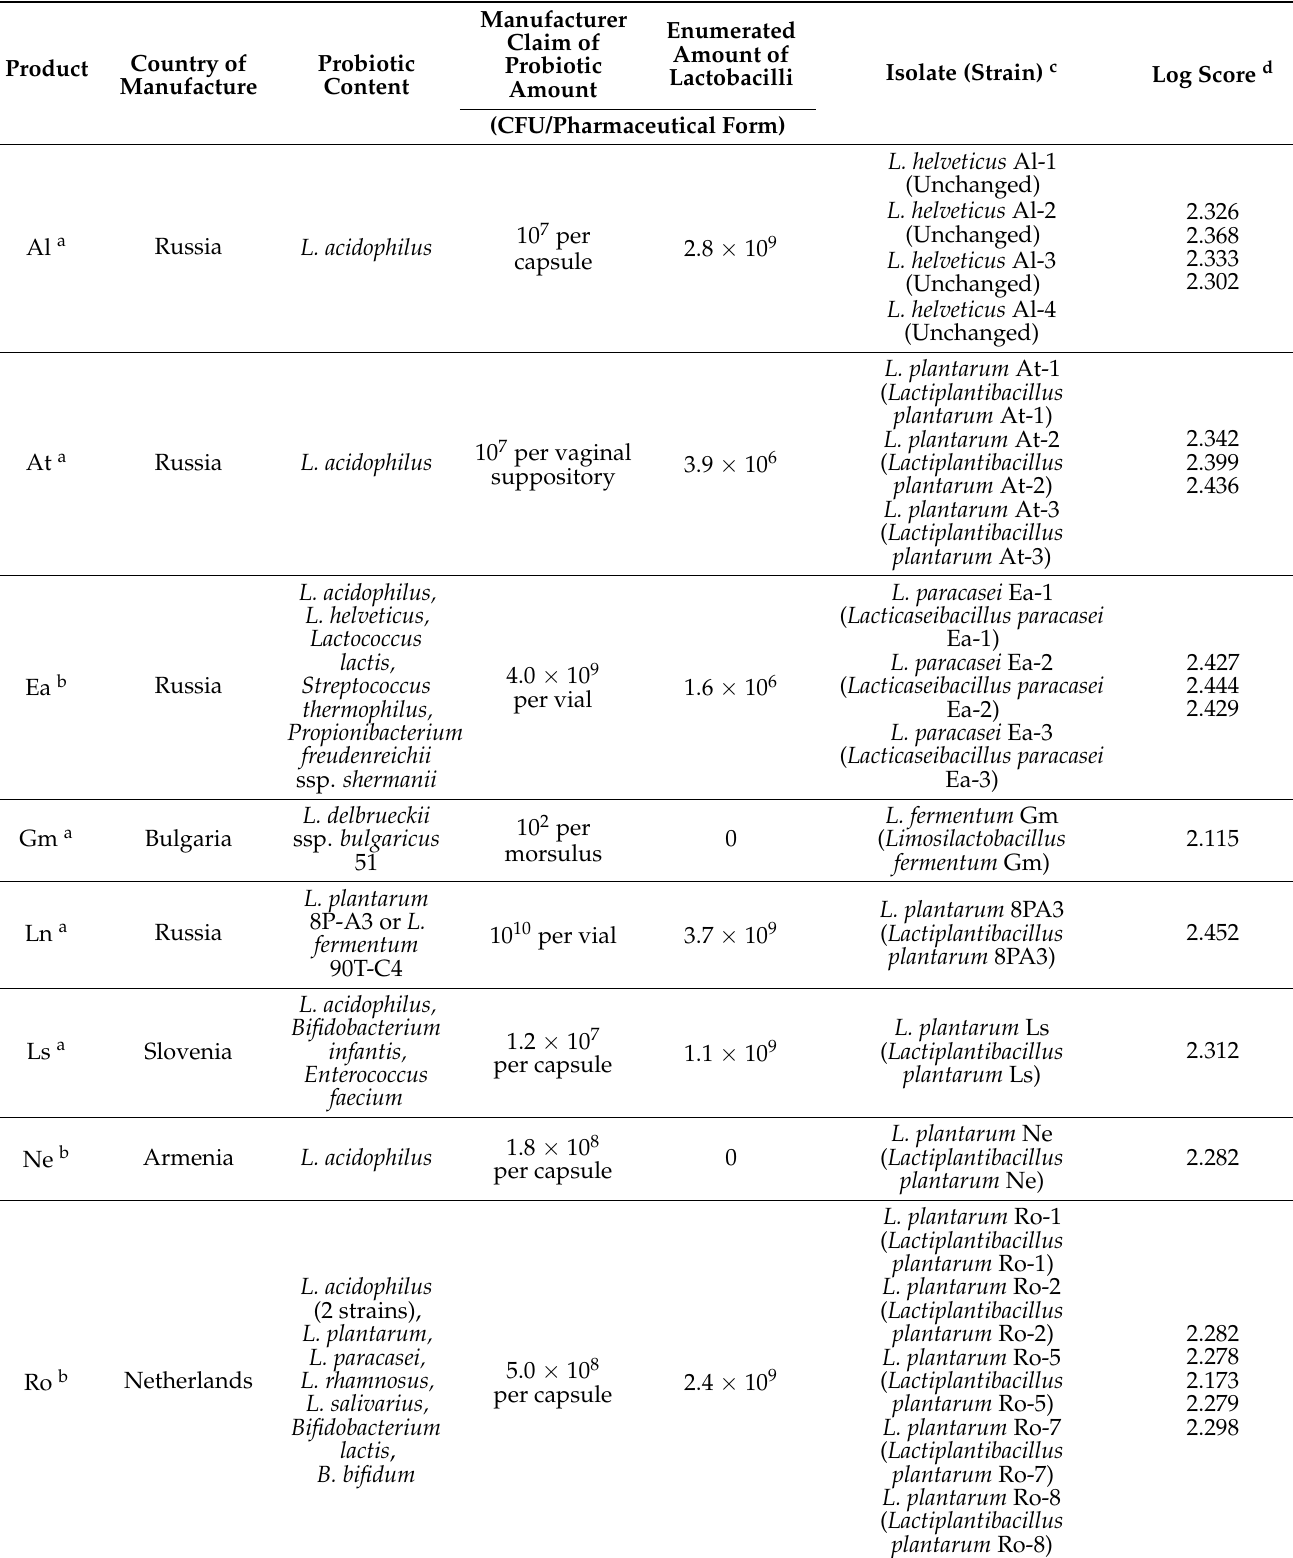
Table 1. Information on probiotic bacteria in probiotic preparations a and dietary supplements b